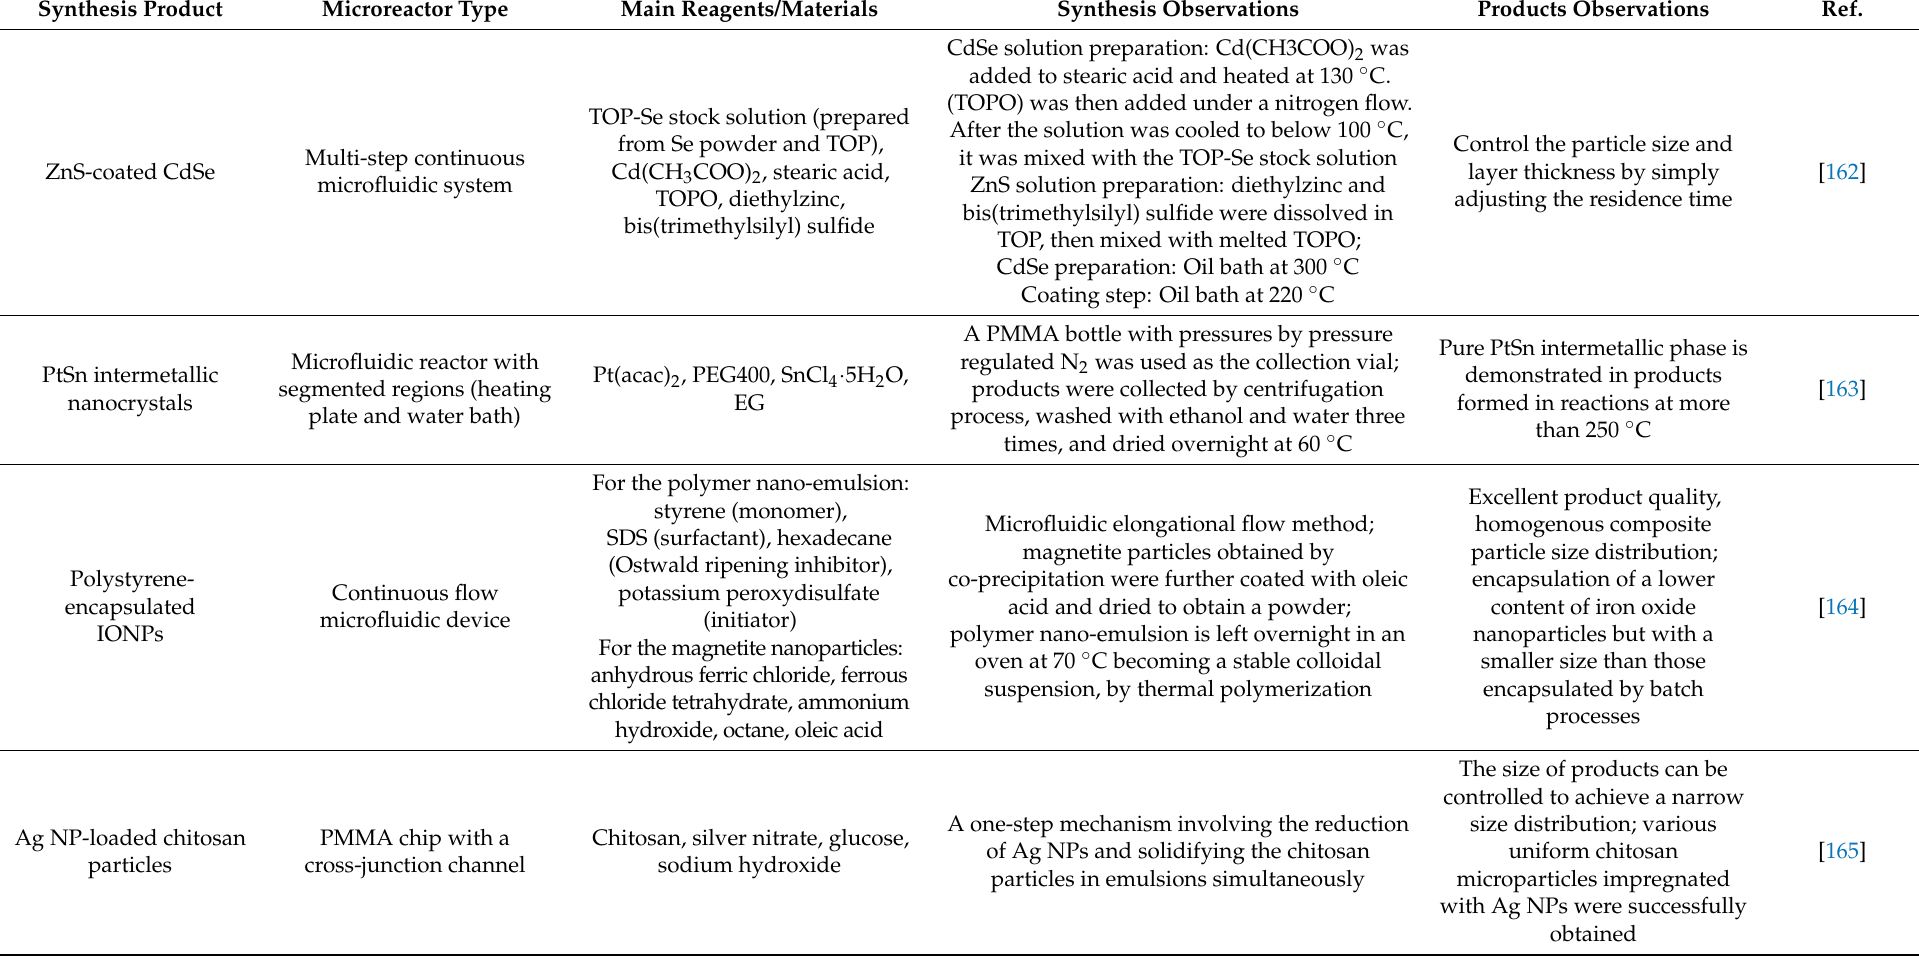
Table 6. Summary of hybrid and composite nanomaterials synthesized via microfluidic